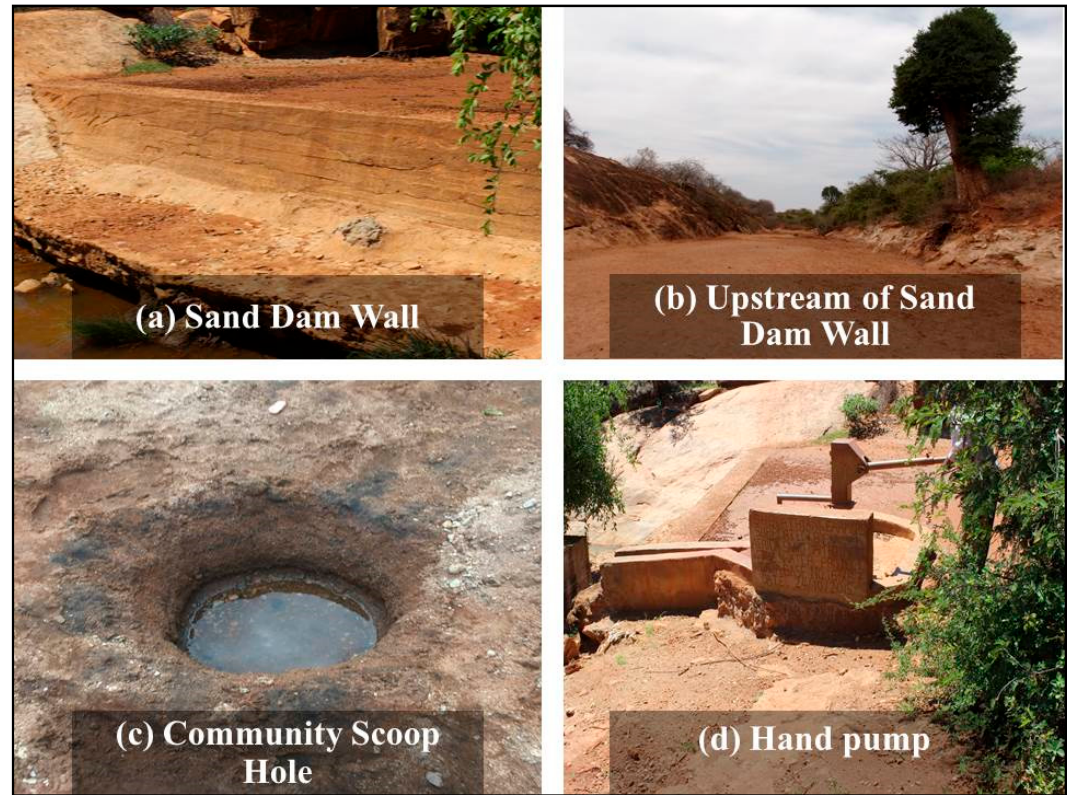
Figure 1. The sand dams and their water abstraction methods.